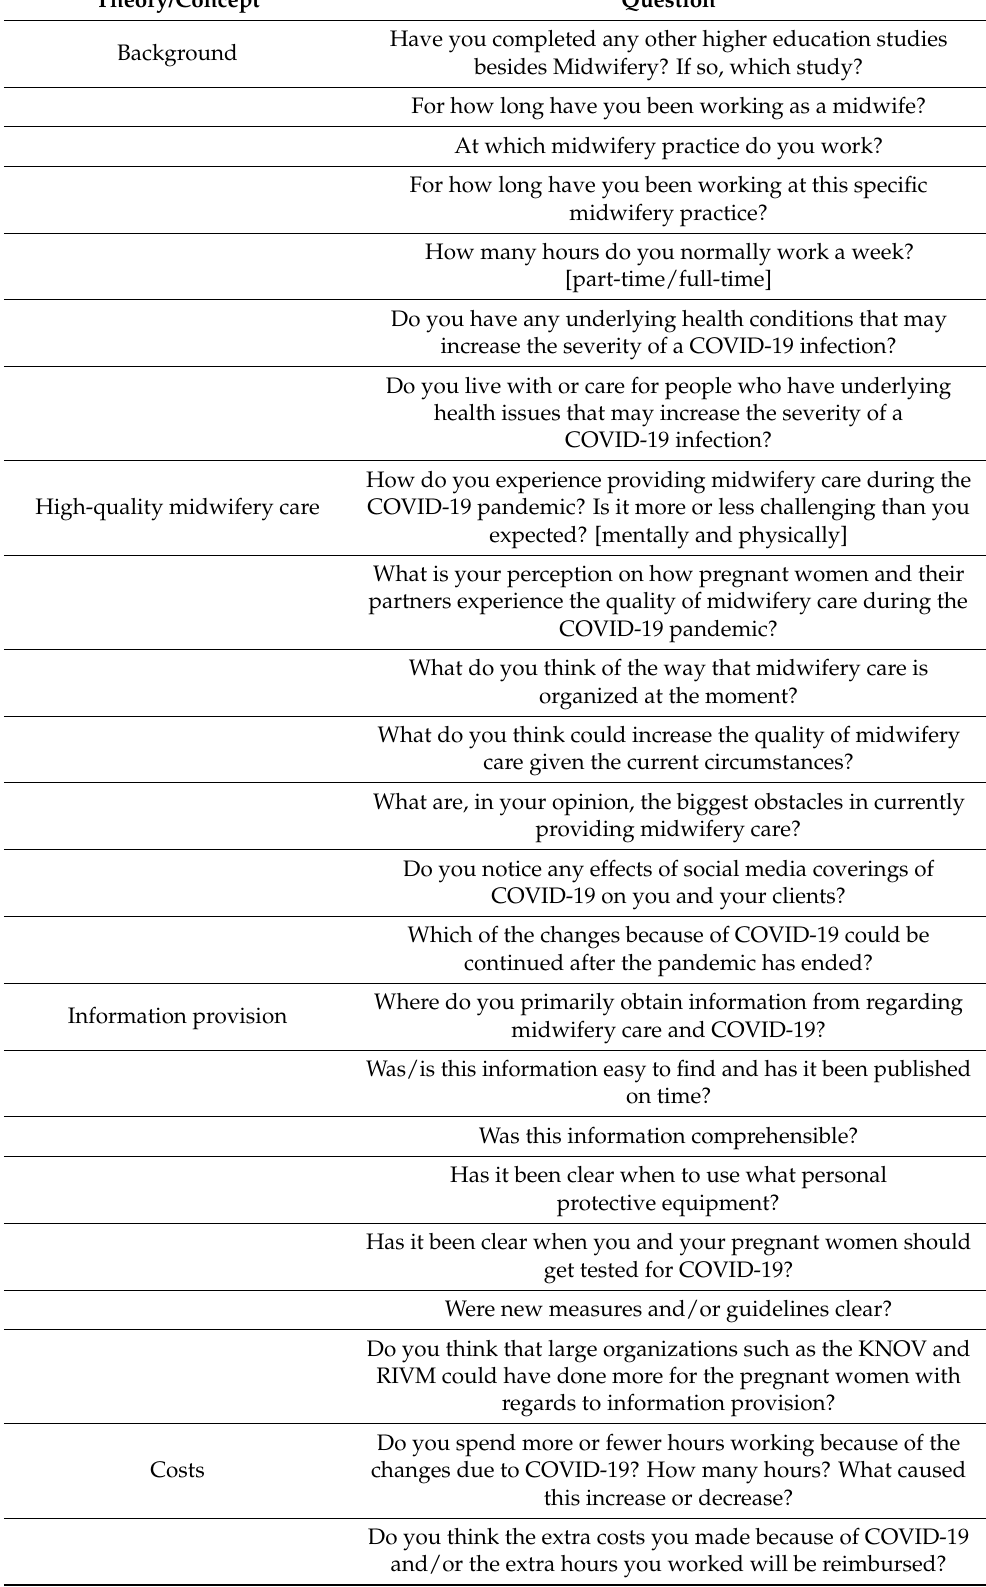
Table 2. Interview guide on the experiences of midwives during the COVID-19 pandemic regarding the quality of